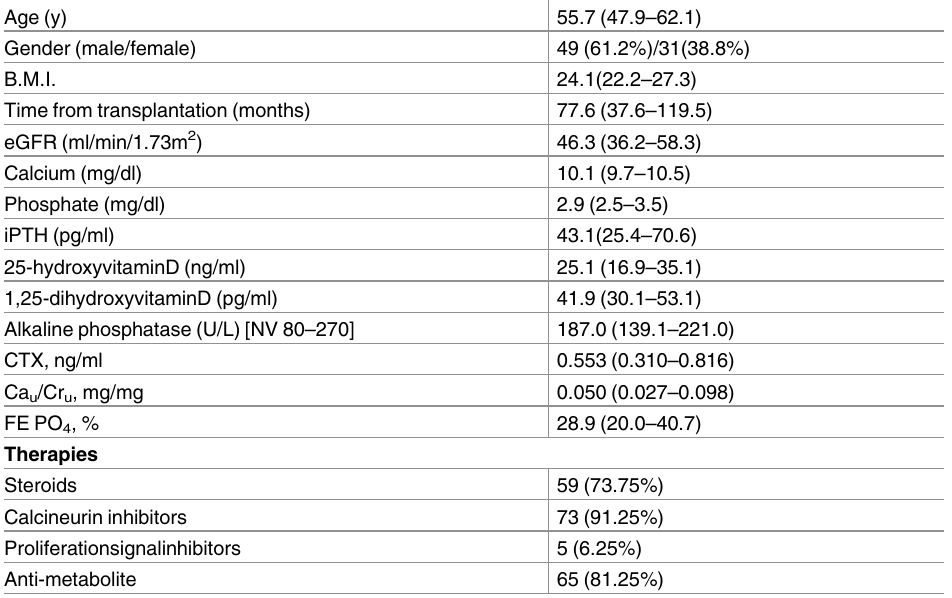
Table 1. Clinical and biochemical characteristics of the population under